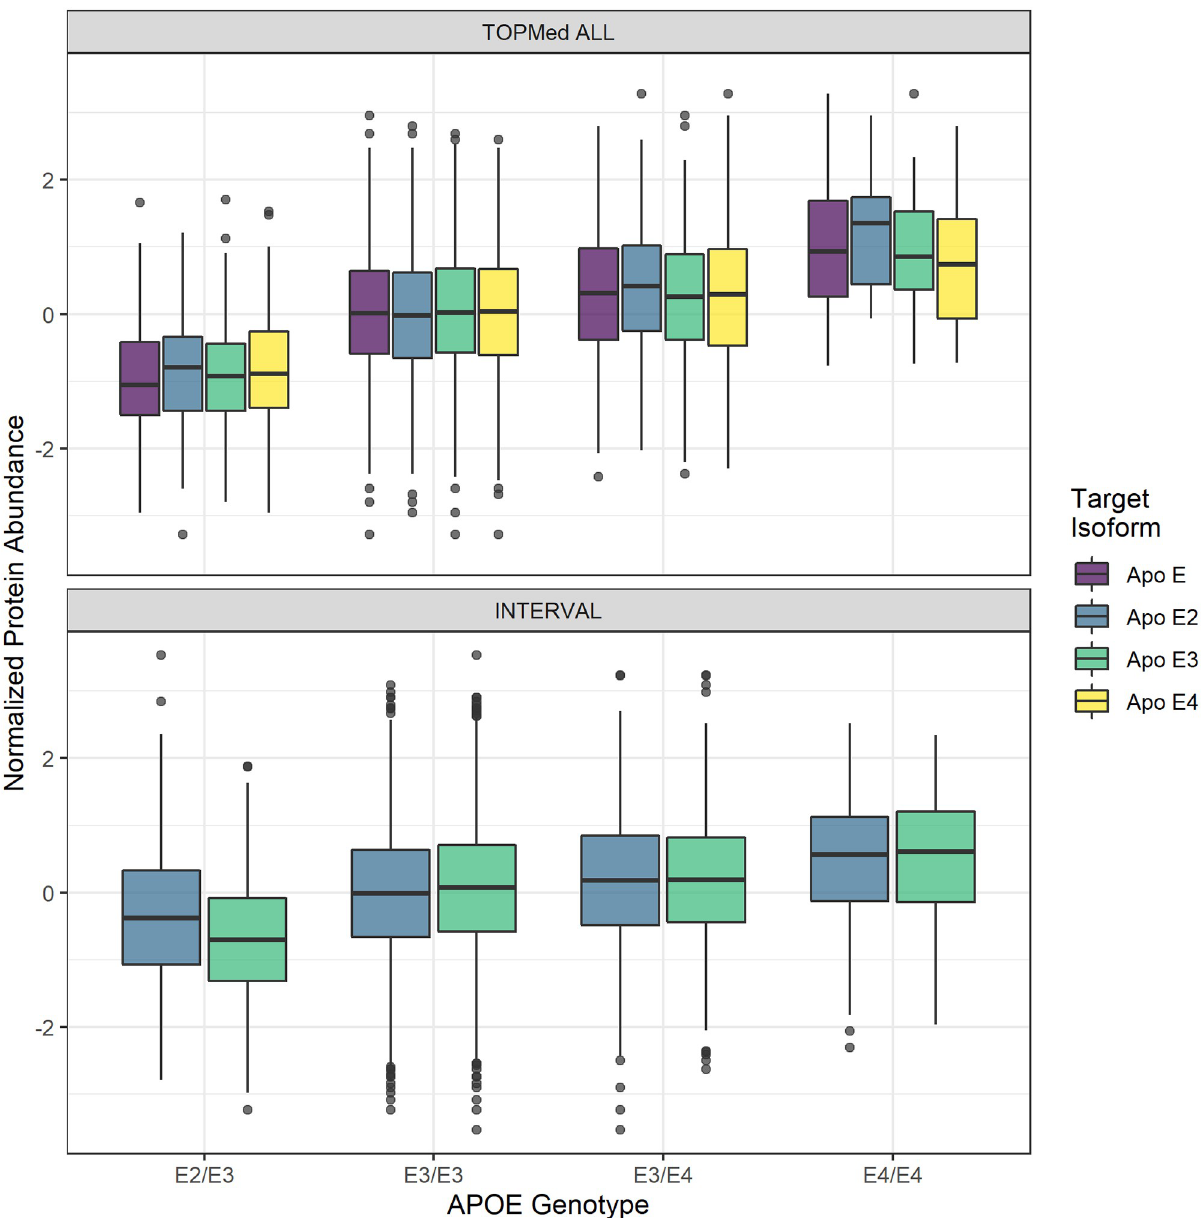
Fig 6. Distribution of adjusted protein abundance. We observe a linear association between APOE genotype and mean abundance of each Apo E isoform. Note that within a genotype, the target isoforms from the SOMAscan assay do not vary, indicating epitope cross-reactivity effects are likely. Top: Association in TOPMed ALL β = 0.498, p = 4.60 × 10 − 27 . Bottom: Association in INTERVAL β = 0.295, p = 1.98 × 10 − 35 . Only two isoforms were available in the INTERVAL dataset.